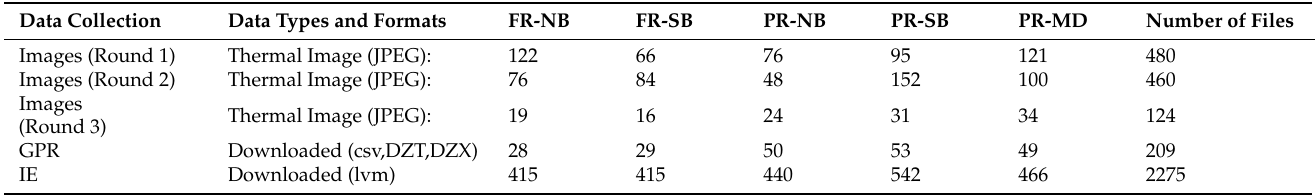
Table 6. Summary of NDE data collected for